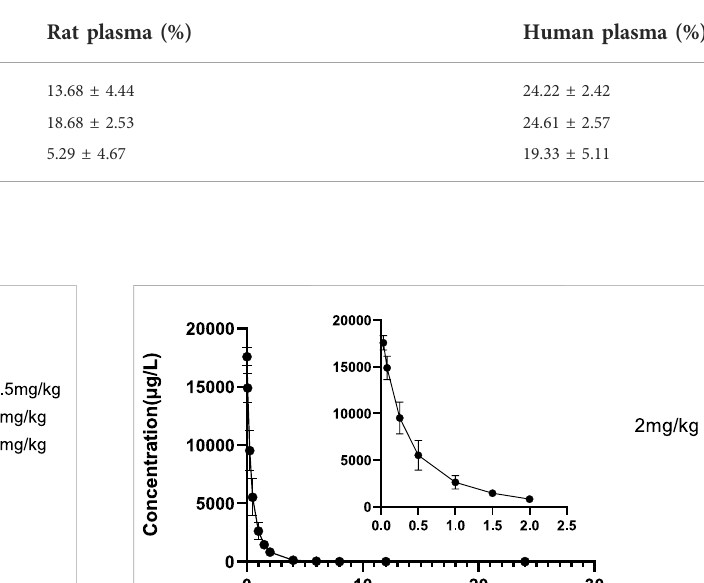
FIGURE 5 Mean plasma concentration-time pro fi le of glytrexate after 12.5, 25, and 50 mg/kg glytrexate was administered to rats ( n = 6). All the glytexate PK values are listed as the mean ± SD. Each mean ± SD ( n = 6) is represented by each point and vertical bar, respectively. Bars represent SD.